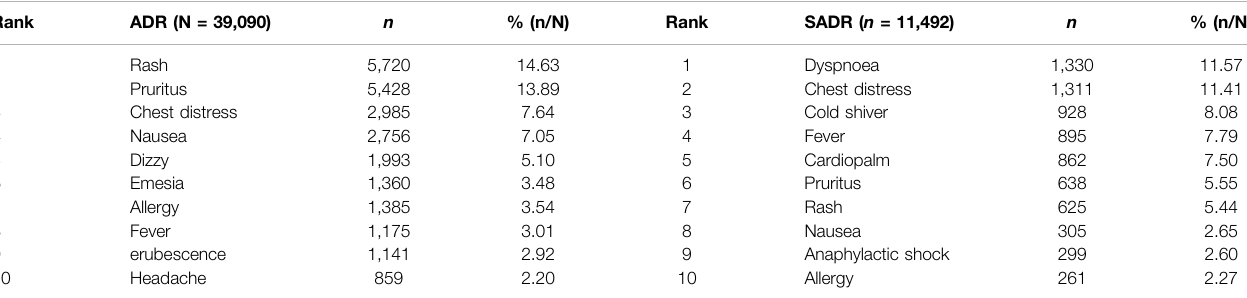
TABLE 4 | Number and proportion of ADRs and SADRs (Top 10).